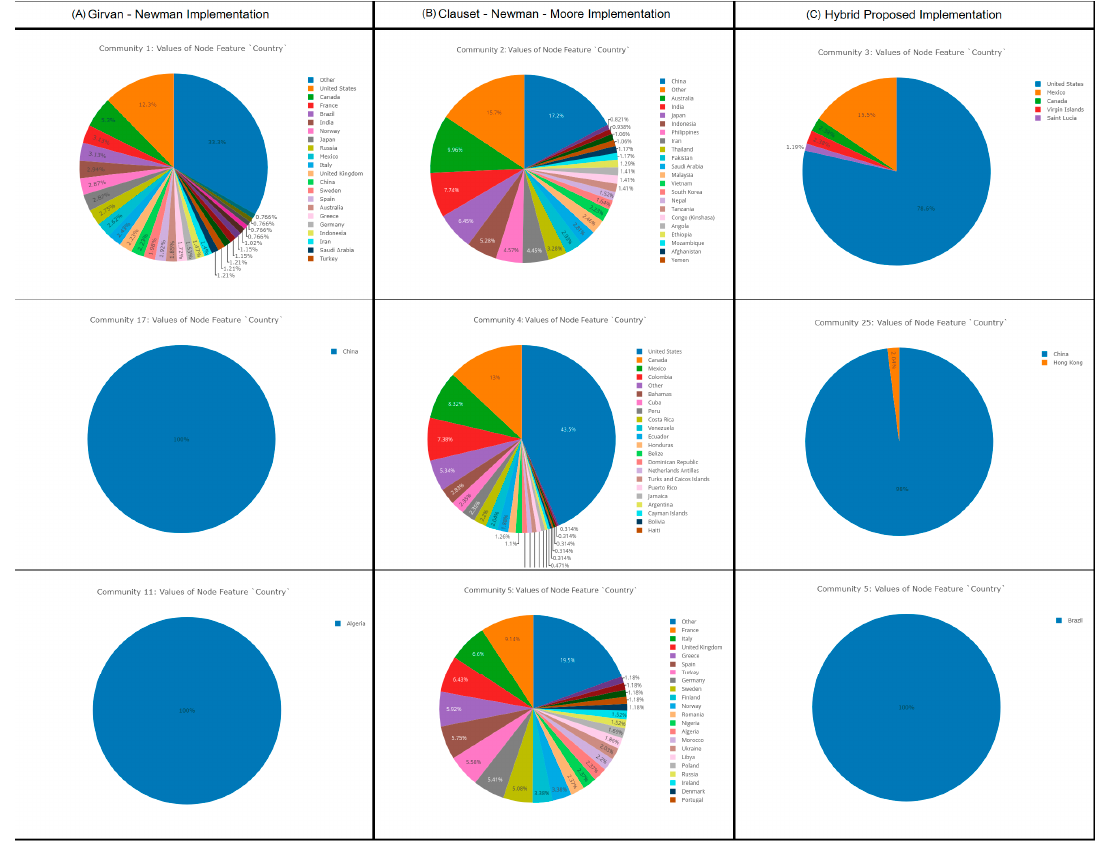
Figure 4. The country distribution for the 3 bigger Openflights generated communities per method applied: ( a ) Girvan–Newman approach; ( b ) Clauset–Newman–Moore implementation; and ( c ) the Hybrid Proposed Methodology.